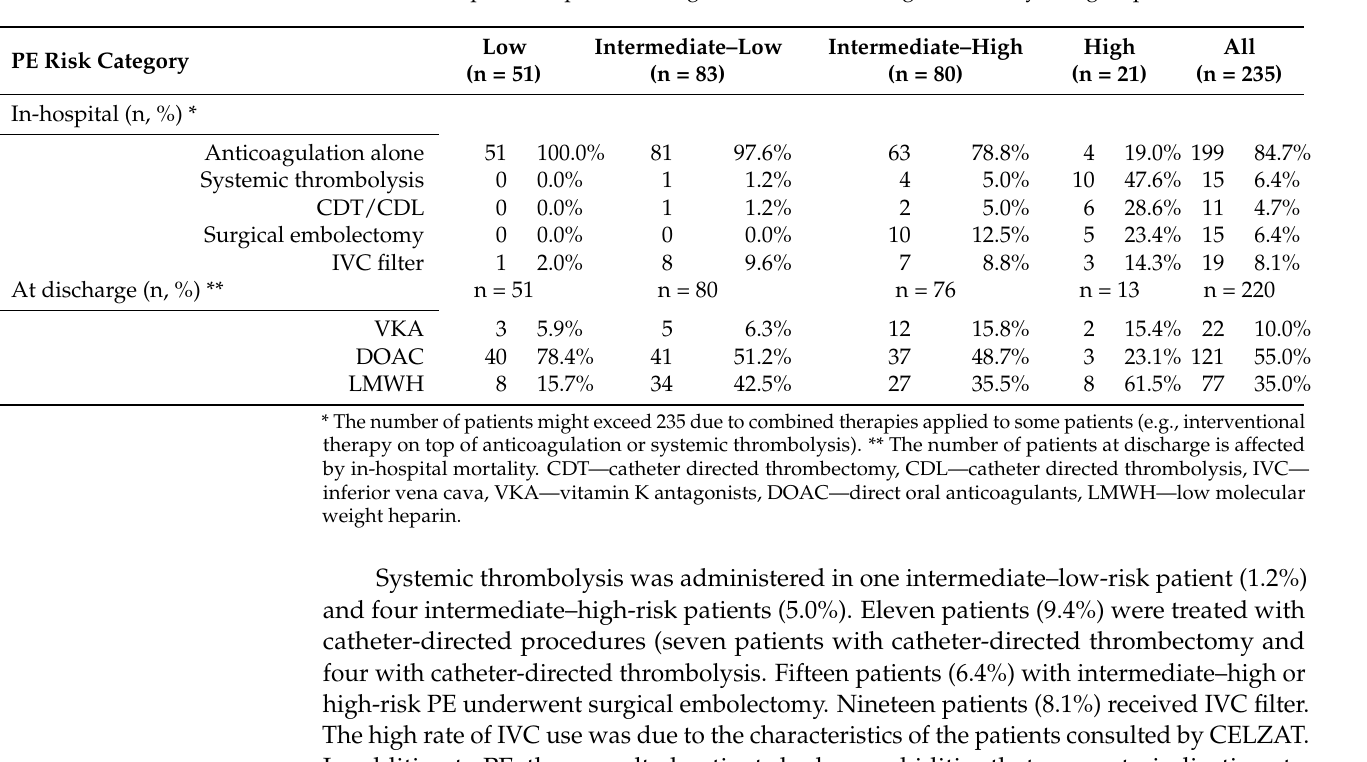
Table 3. In-hospital and post-discharge treatment according to mortality risk